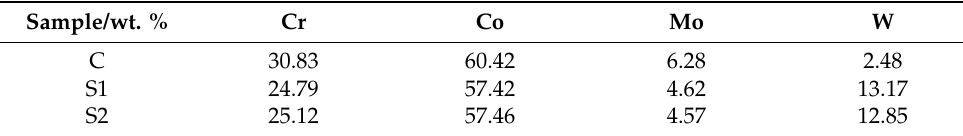
Table 2. EDX chemical composition in (wt. %) for selected samples. Sample/wt.